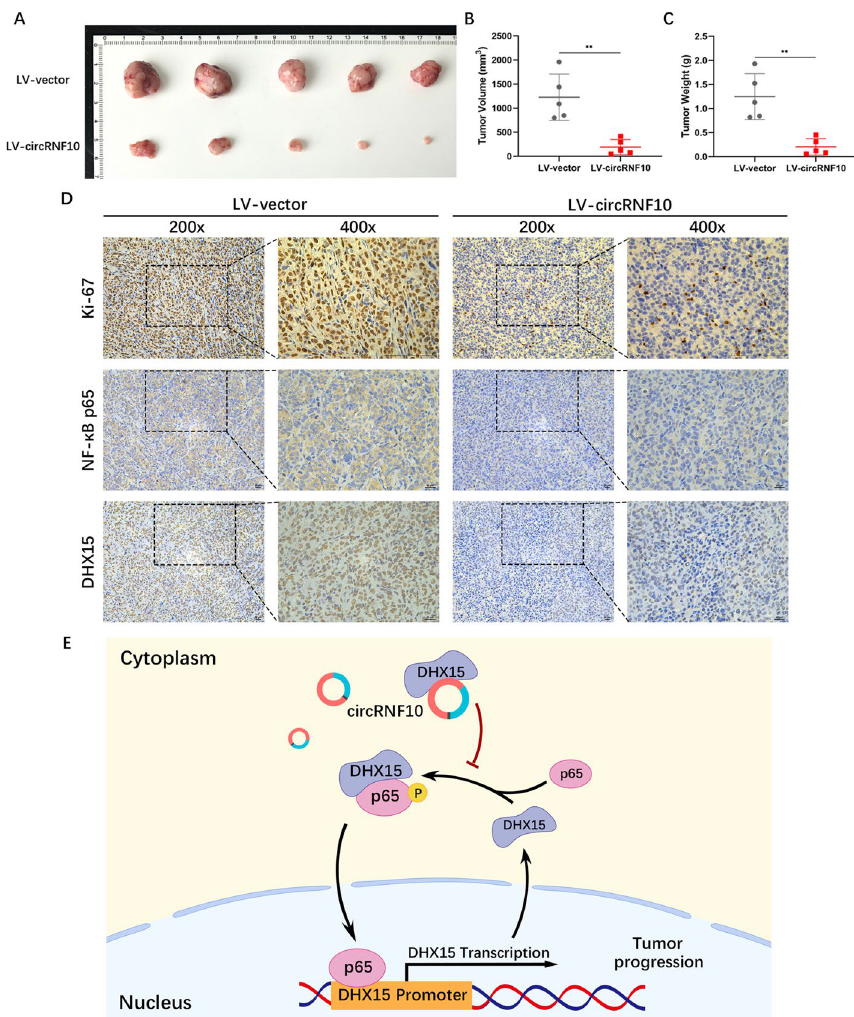
Fig. 7 CircRNF10 suppressed BC growth in vivo. A Photograph of tumors in female BALB/c nude mice injected with LV-vector or LV-circRNF10 MDA-MB-231 cells ( N of tumors in LV-vector group and LV-circRNF10 group. C The weight of tumors in LV-vector group and LV-circRNF10 group. D Representative IHC images showing the expression of Ki-67, p65, and DHX15 in tumors of LV-vector group and LV-circRNF10 group. E Schematic illustration showing the mechanism of circRNF10 in inhibiting BC progression. Error bars represent the mean **** P <